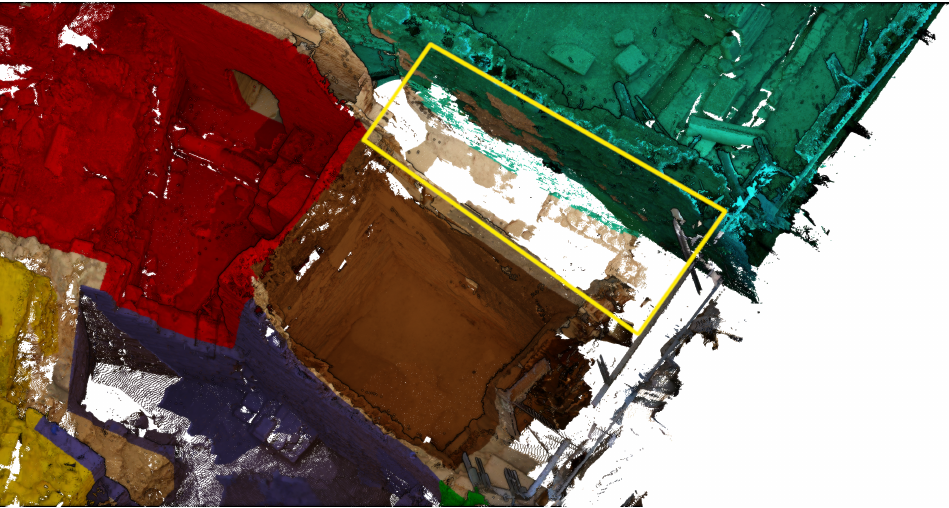
Figure 16. The unrecognized watermill composed of the large room (in brown) and the narrow room (framed in